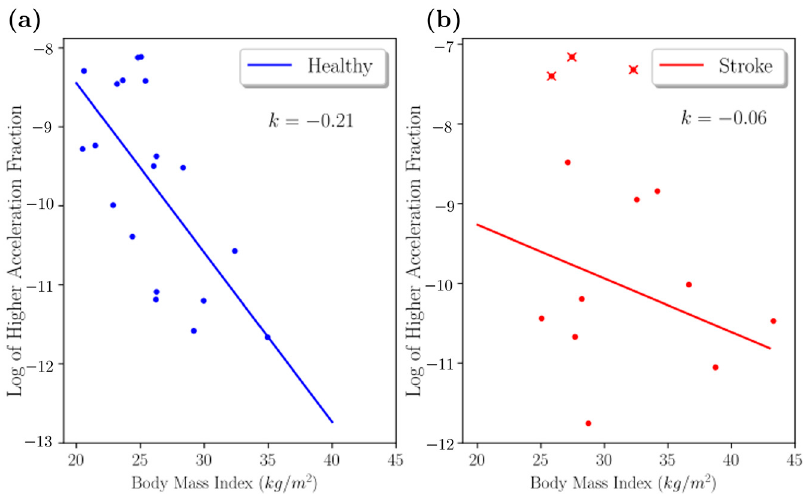
Figure 6. ( a ) Relationship between higher-acceleration fraction with healthy participant BMI. ( b ) Relationship between higher-acceleration fraction with stroke participant BMI. The figure shows three outliers as red x data points.